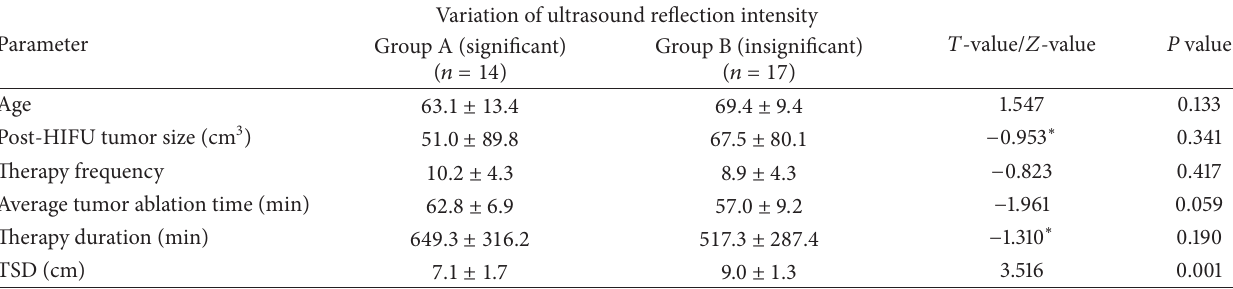
Table 2: Impact of the variables on variation of ultrasound reflection intensity.